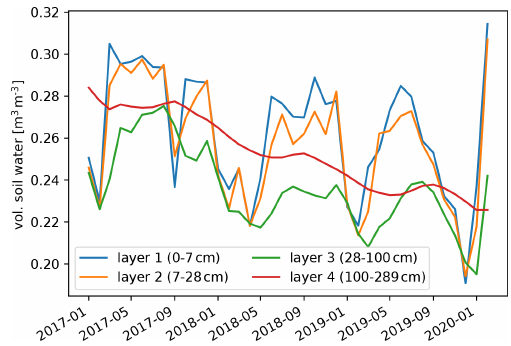
Figure 8. ERA5 volumetric soil water from multiple levels. The data represent the spatial average over the study area. Please note that the date format in this figure is year month